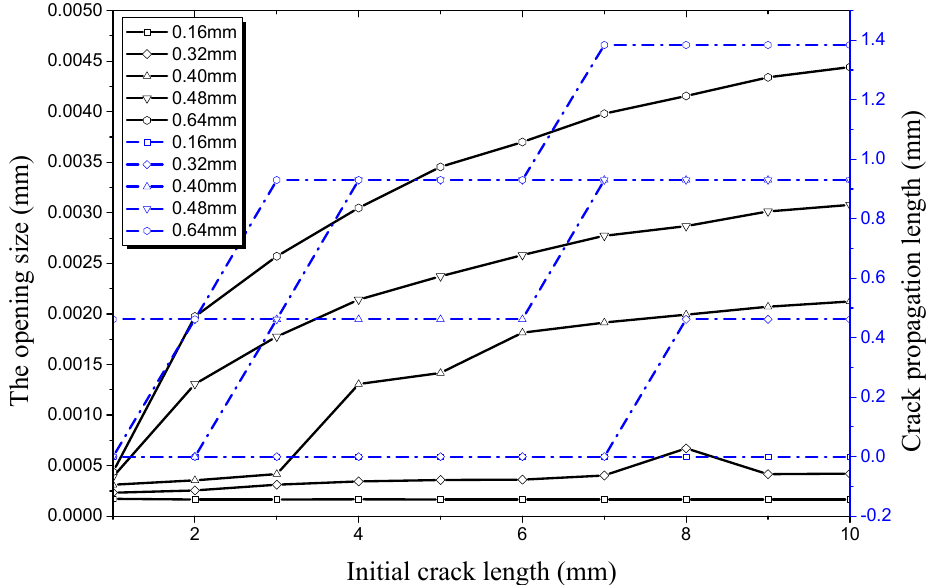
Figure 15. Relationship between longitudinal crack propagation length and initial crack length on the outer surface, and relationship between longitudinal opening size and initial crack length on the outer surface, both under an internal pressure of 28 MPa.